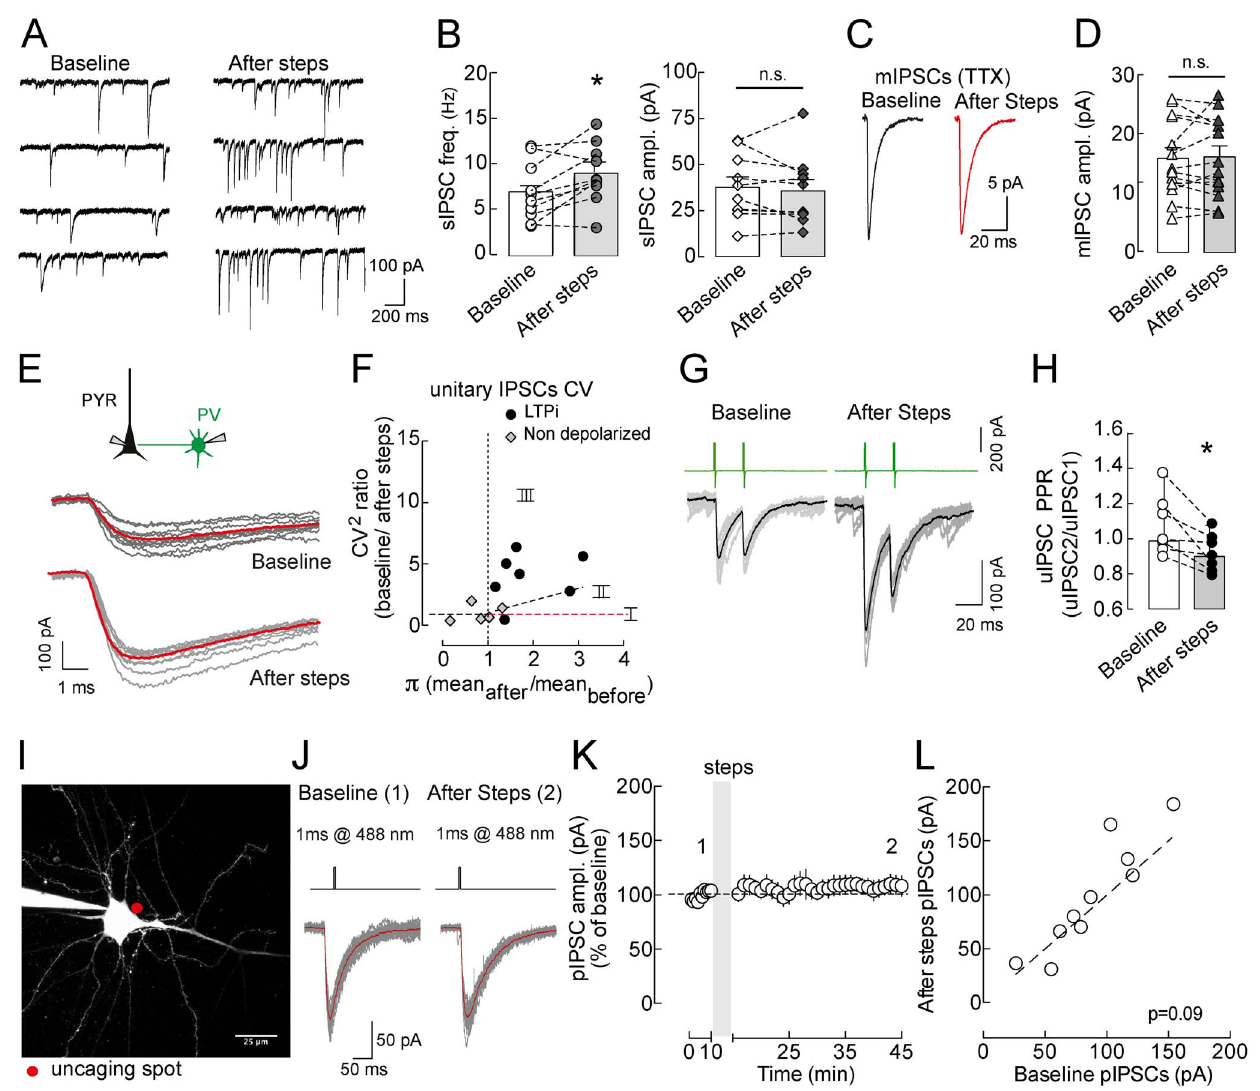
Figure 4. LTPi is expressed presynaptically. (A) Representative traces of spontaneous IPSCs (sIPSCs) during baseline and after LTPi induction. (B) Summary graph of sIPSC frequency (Left) and amplitude (Right) before (white bar, open circles) and after steps (grey bar, solid circles). Data are values from single cells and/or mean 6 SEM. * p , 0.05 as compared to baseline. (C) Average representative traces of mIPSCs recorded in the continuous presence of tetrodotoxin (TTX, 500 nM) before (black trace) and after (red trace) depolarizing steps. Each trace is the average of , 100 single quantal events. (D) Population plot of mIPSC amplitudes before (empty symbols) and after depolarizing steps (filled symbols). n.s., not statistically significant ( p . 0.05). (E) Representative traces of PV basket cell–pyramidal neuron uIPSCs before and after LTPi; grey traces are overlapped single-sweep responses. Note the decrease in peak amplitude fluctuations of single responses during LTPi. This is associated with an increase of the mean response (red traces). (F) Analysis of the squared coefficients of variations of PV cell–pyramidal neuron uIPSCs (CV 2 1/CV 2 2) as described by Faber and Korn [59]. The numbers 1 and 2 refer to baseline and after depolarization values, respectively. According to this analysis, CV 2 values on the horizontal line (I) reflect a postsynaptic potentiation, whereas cells in region II (above the diagonal linear fit line) showed a presynaptic LTPi expression. Values in region III refer to P neurons with a mixed pre- and postsynaptic LTPi expression. Overall, apart from few exceptions, LTPi had a presynaptic expression locus (above region II). Cells that did not express LTPi (grey diamonds) did not show IPSC CV 2 changes compatible with synaptic potentiation. (G) Representative traces of two PV cell–pyramidal neuron uIPSCs evoked at 20-ms intervals, before (Left) and 20 min after (Right) LTPi. Grey traces are overlapped single sweeps; black lines are averaged traces. (H) Population data of PPR in baseline (white bar, open circles) and 20 min after depolarization (grey bar, solid circles). Note a decrease in PPR after the steps, indicating a change (an increase) in the probability of GABA release. Data are single values and/or mean 6 SEM. ** p , 0.01 as compared to baseline. Further analyses are illustrated in Figure S1. (I) 2PSLM image (maximal intensity projection) of a layer 5 pyramidal neuron loaded with Alexa 594 (20 m M). The red dot shows the size ( , 5 m m) and location of the uncaging spot on the perisomatic region. (J) 1 ms, 488 nm laser pulse elicited pIPSC (individual traces in grey and average in red) before and in the time window between 20 and 30 min after depolarizing steps. (K) Population data show no change in pIPSC amplitude after steps. (L) Correlation plot of pIPSC amplitudes in control versus 20 min after LTPi-inducing depolarizing steps.